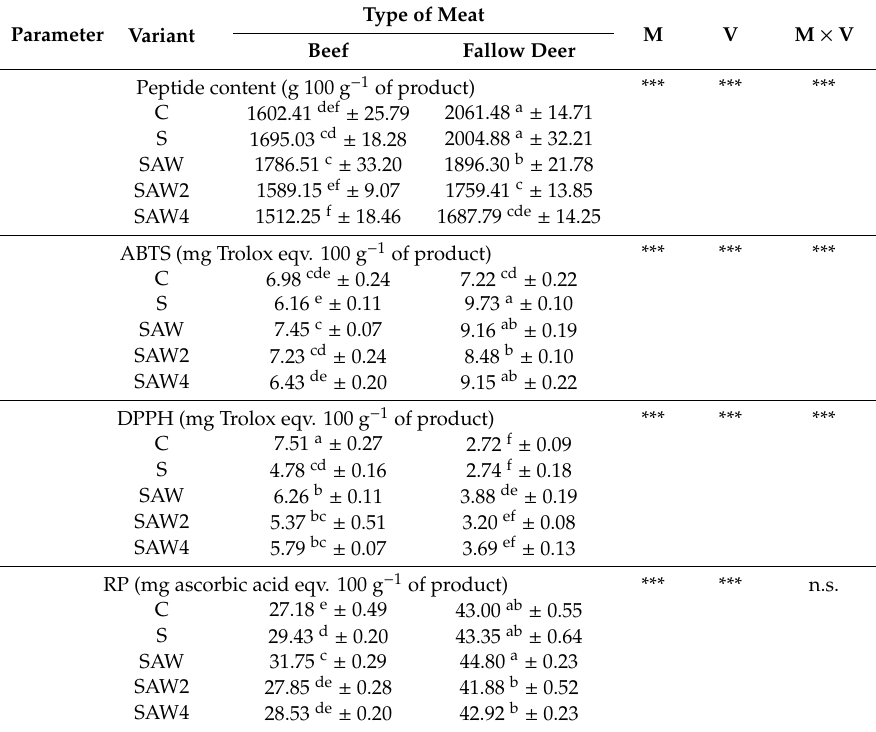
Table 3. Content of peptide in fermented sausages made from beef and fallow deer meat with di ff erent additives and their antioxidant activity measured as ability to scavenge DPPH and ABTS + radical and reducing power (RP, mean ± standard error).